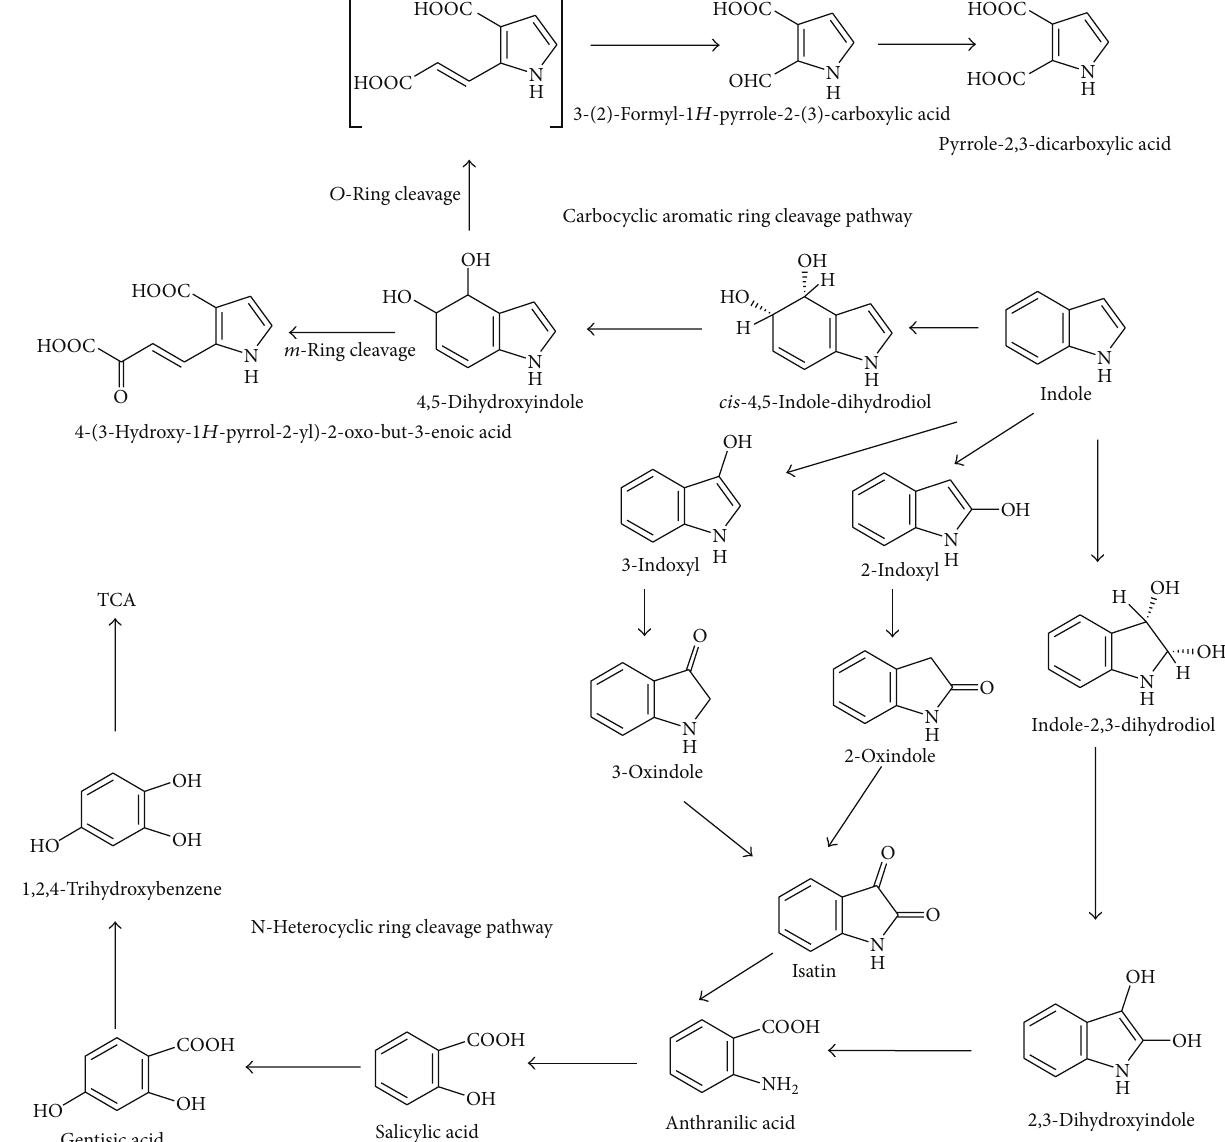
P. mendocina KR1 [53], styrene-degrading P. putida